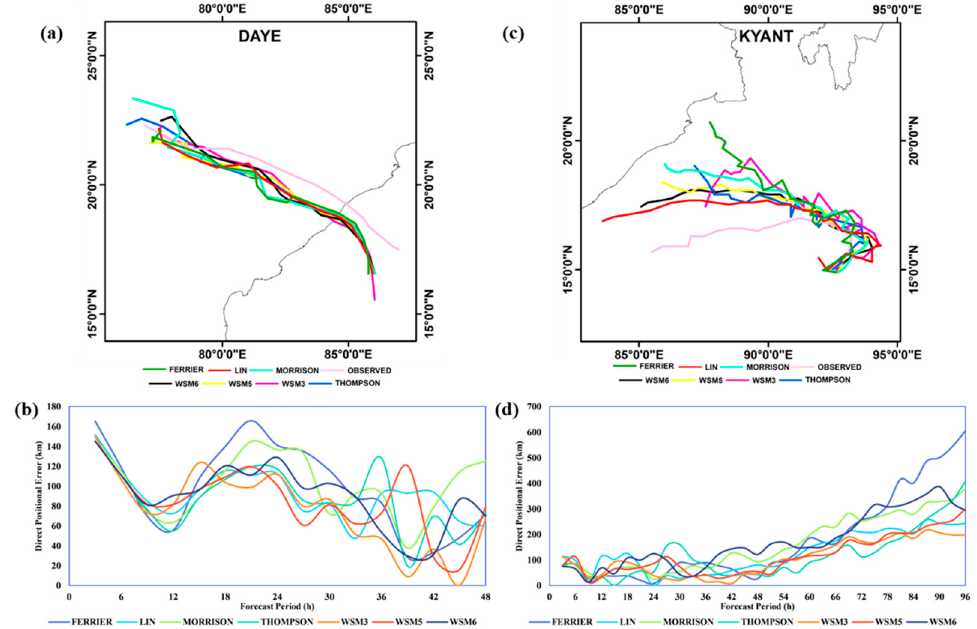
Figure 2. Observed and predicted tracks of tropical cyclones initiated at depression stage along with DPE ( a ) tracks of Daye Cyclone, ( b ) DEP of Daye Cyclone, ( c ) track of Kyant Cyclone, ( d ) DEP of Kyant Cyclone.